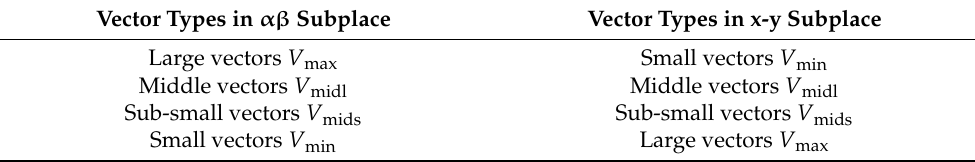
Table 2. Mapping relationship of the same vectors in different subplaces.